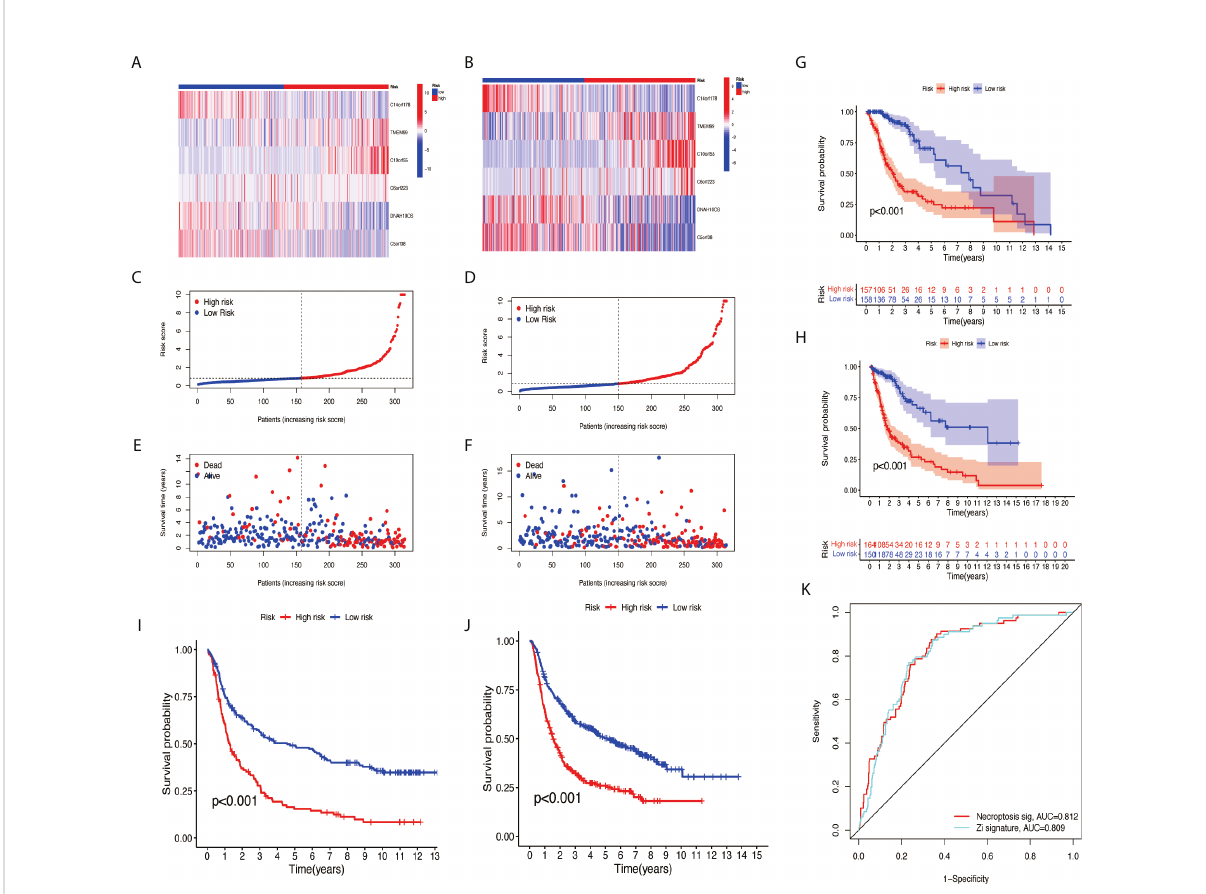
FIGURE 5 Validation of necroptosis-related lncRNA prognosis signature. (A, C, E) The risk score and patients are distributed based on the risk score in the training group. (B, D, F) The risk score and patients are distributed based on the testing group ’ s risk score. (G) The survival curves in the training group. (H) The survival curves in the testing group. (I) The survival curves in CGGA325. (J) The survival curves in CGGA693. (K) ROC curves between two models. lncRNA, long non-coding RNA; ROC, receiver operating